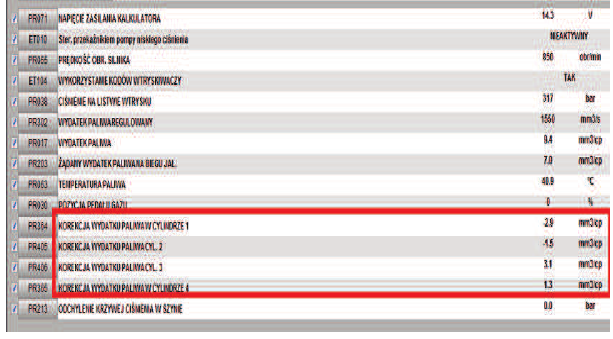
Fig. 4 Correction doses control for CR